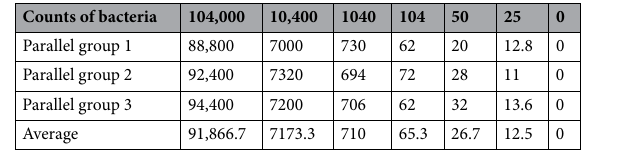
Table 6. Detecting Staphylococcus aureus ATCC25923 nucleic acid extracted from the simulated bacteremia blood